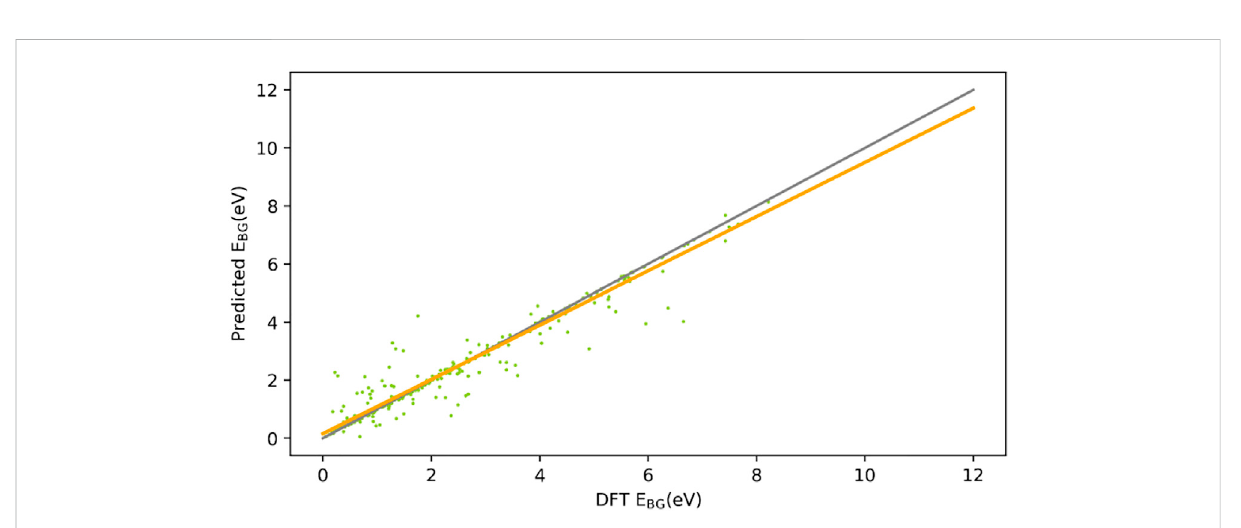
FIGURE 7 Fitted plot of two elemental compound predict Egap and DFT